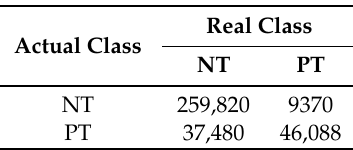
Table 7. The confusion matrix for Random Forest over Risk Stratification between normotension (NT) and prehypertension (PT).